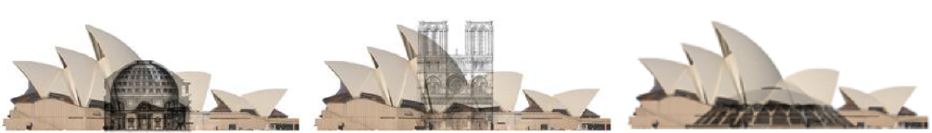
Figure 16. Sydney Opera House building size (67 m height above sea level, 186 m in length) compared to Pantheon (Rome, 27 B.C.; left ), Notre Dame (Paris, 1345; center ), and Palazzetto dello Sport (Rome, 1960; right ).